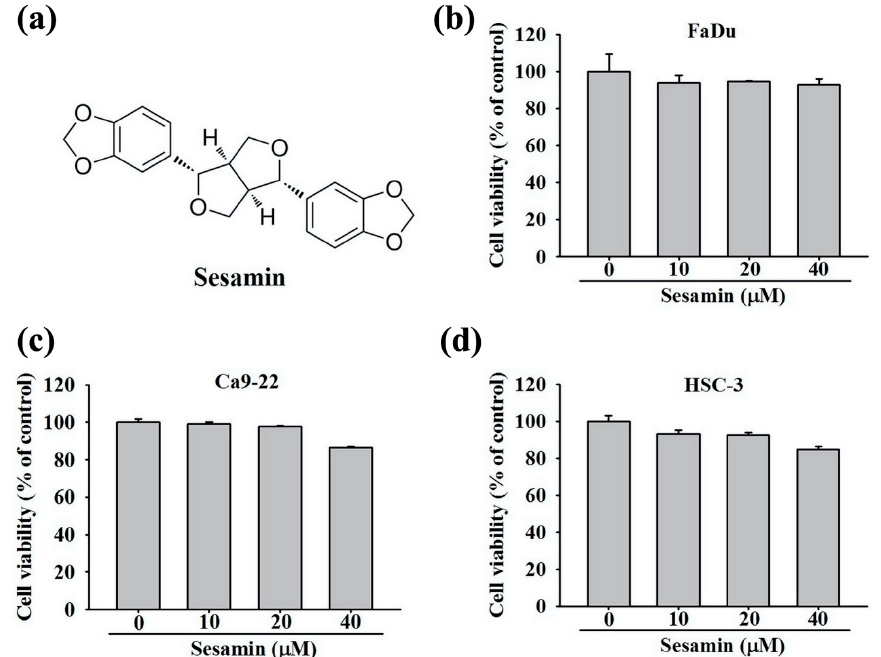
Figure 1. Cell viability of human oral cancer cells following sesamin treatment. Human oral cancer cell lines FaDu, Ca9-22, and HSC-3 were treated with sesamin (0, 10, 20, and 40 µ M) for 24 h and then subjected to MTT assays for cell viability analysis ( a ) Chemical structure of sesamin (SES). ( b ) FaDu, ( c ) Ca9-22, and ( d ) HSC-3 cell viabilities displayed as percentages. The values represent the means ± SD of at least three independent